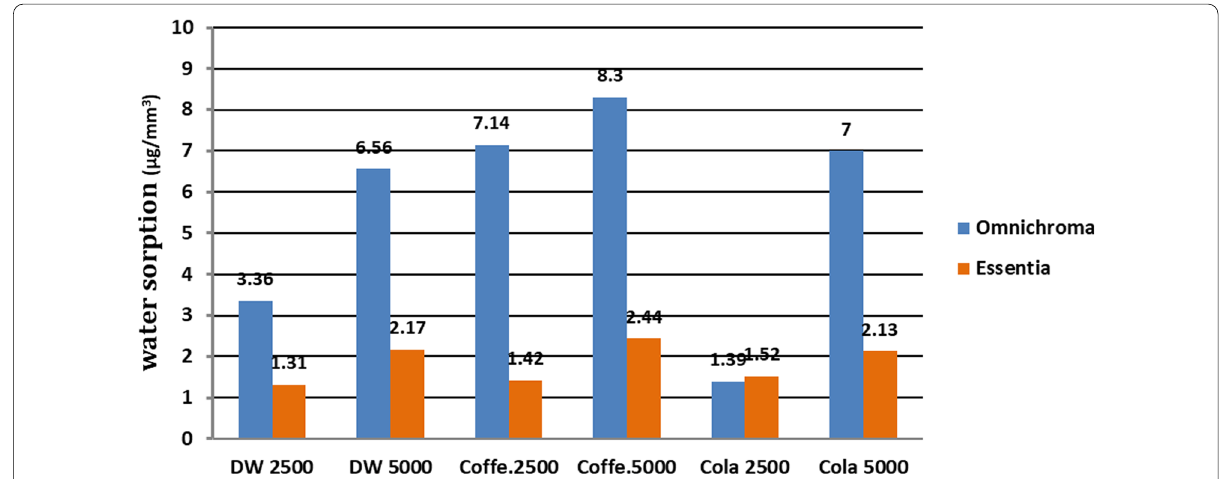
Fig. 2 The histogram showed water sorption values after TC 2500 and 5000 of Omnichroma and Essentia composite